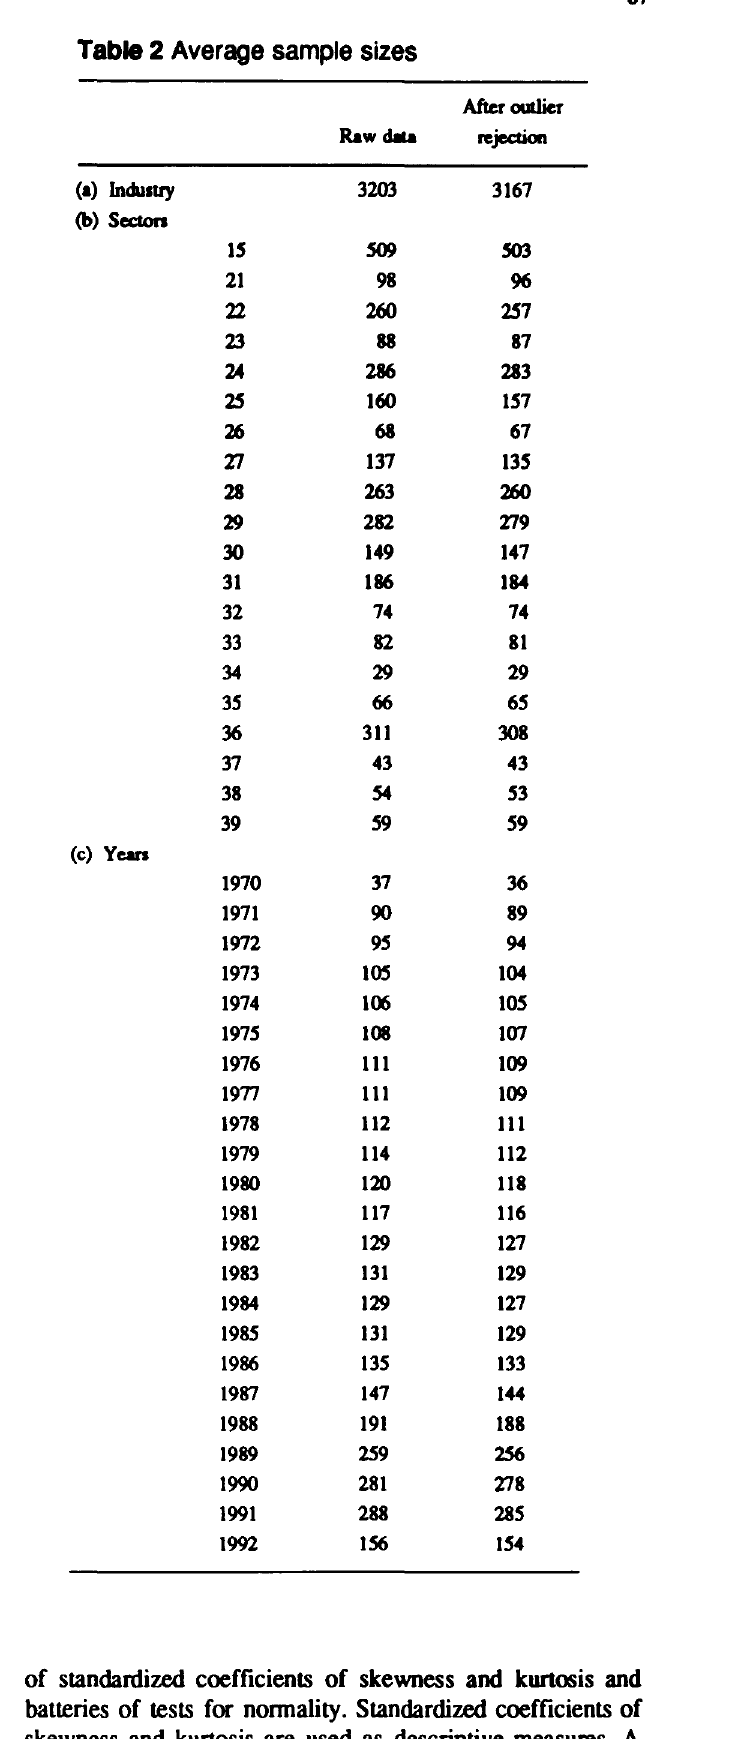
Table 2 Average sample